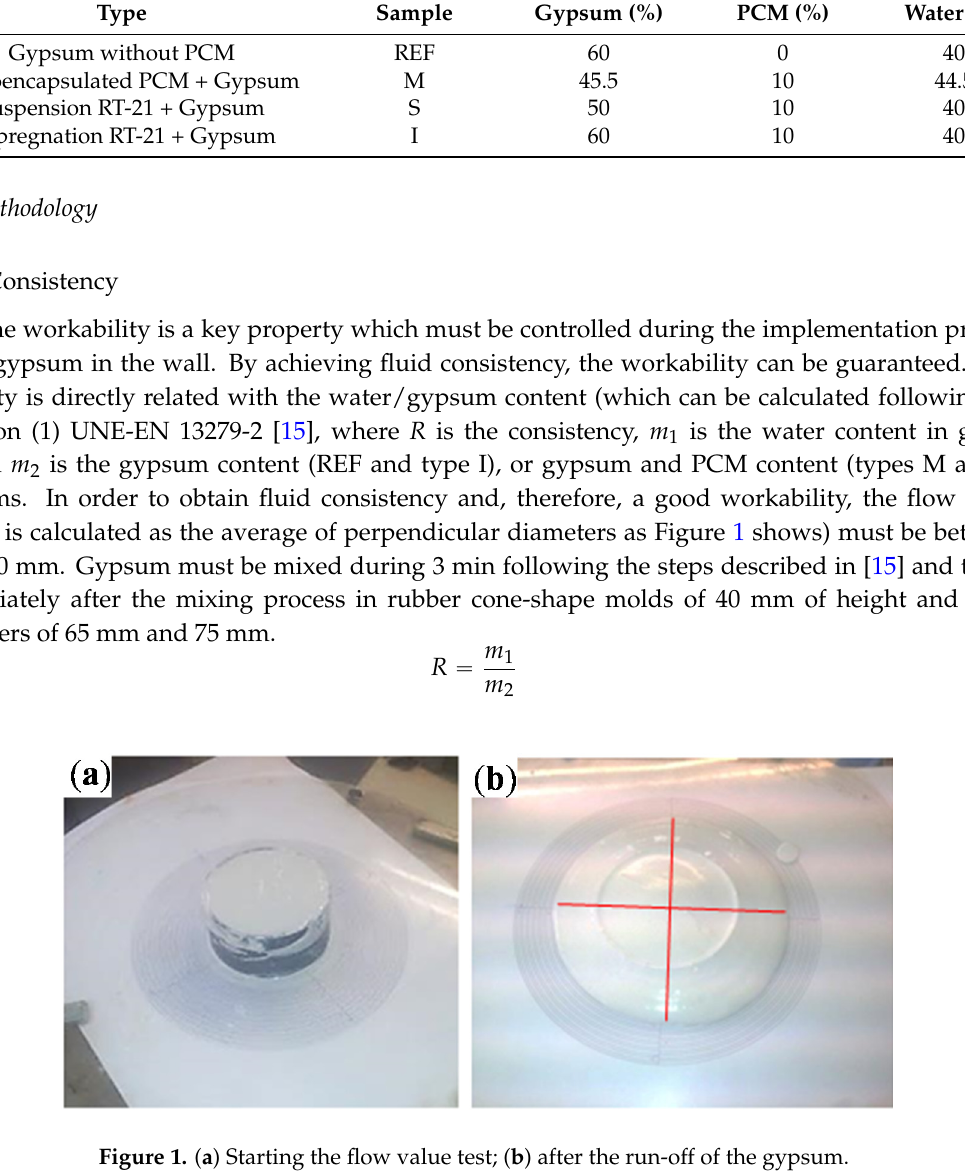
Figure 2. ( a ) Vicat needle; ( b ) Adherence test. 2.2.3. Adherence Figure 2b shows KN-10 of Neurtek (Eibar, Spain) where the adherence of gypsum is tested. The adherence is tested and calculated following Equation (3) where R u is the adherence force, F u in